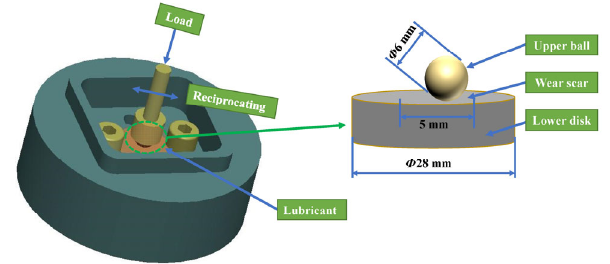
Fig. 1 Schematic of tribological tests.